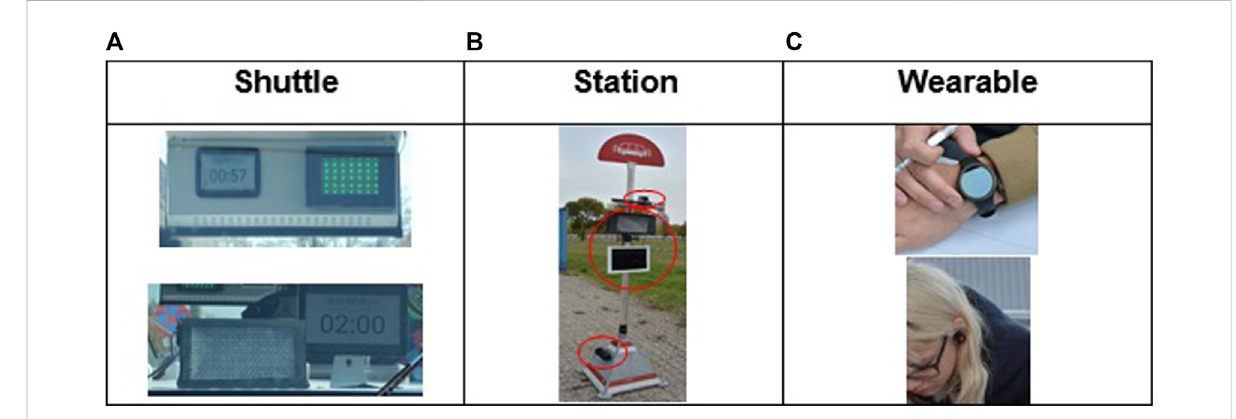
FIGURE 23 (A) Locations of screen and animations (LED array) on the bus interior facing inwards (picture at the top) and behind the windscreen facing outwards (bottom); the loudspeaker was mounted below the seats; (B) : locations of color animation (LED display at the top), screen (tablet in the middle), and loudspeaker (bottom); (C) : wearable (smartwatch) at the wrist (top) and bluetooth earplugs